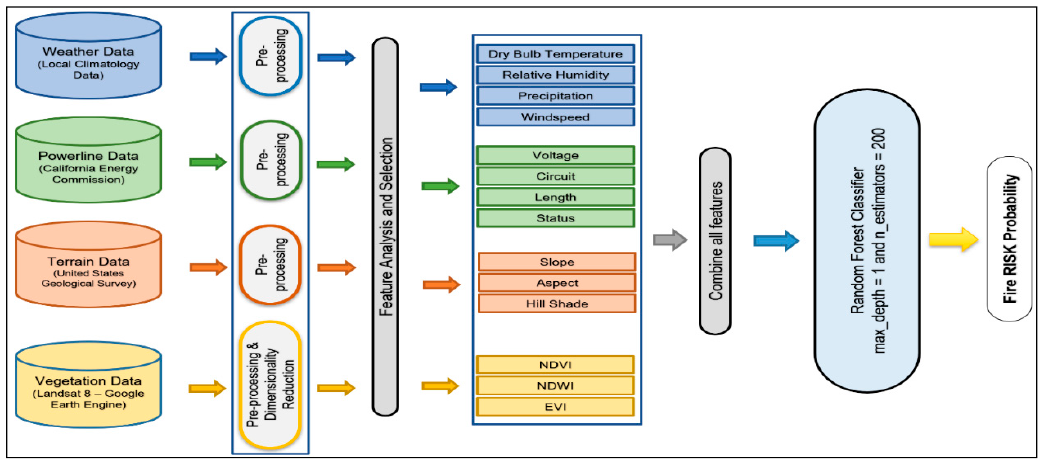
Figure 10. Architecture of the Combined dataset Random Forest